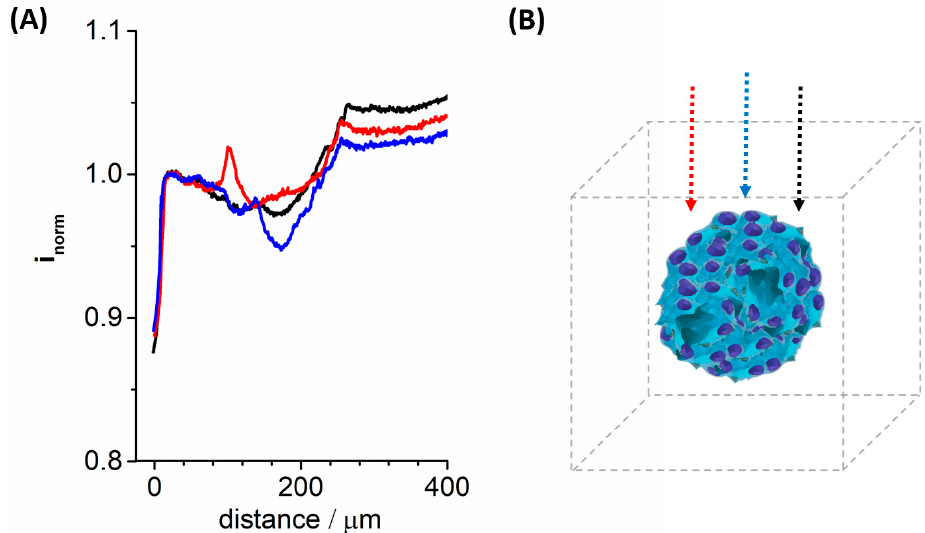
Figure 8. SECM measurements of oxygen concentration inside spheroids with a diameter of ~250 µm. ( A ) The three different measurements were made inside the same spheroids in adjacent sections. The blue curve is oxygen concentration measured in the longer spheroid diameter (blue arrow in panel B ); black and red curves are measurements performed on more peripheral parts of the spheroid (black and red arrow, respectively, in the panel ( B ). Measurements were performed using a 200–500 nm Pt UME at − 0.7 V vs. Ag/AgCl (KCl 3 M) with a scan rate of 10 µm/s in PBS solution. These measurements are representative of three measurements performed on three different spheroids. The current detected at the nanoelectrode has been normalized (i norm ) with respect to that measured at a fixed distance from the bottom of the Petri dish and outside the spheroid, in this case this distance was 28 µm.